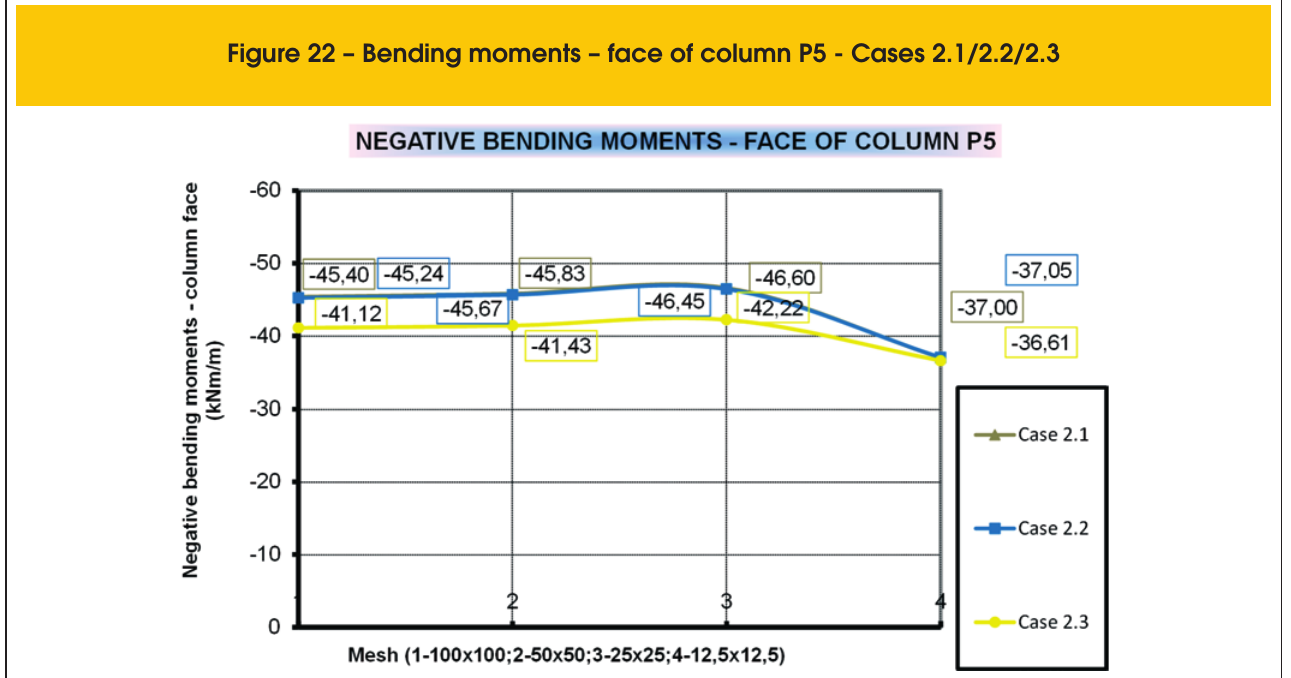
Figure 22 – Bending moments – face of column P5 - Cases